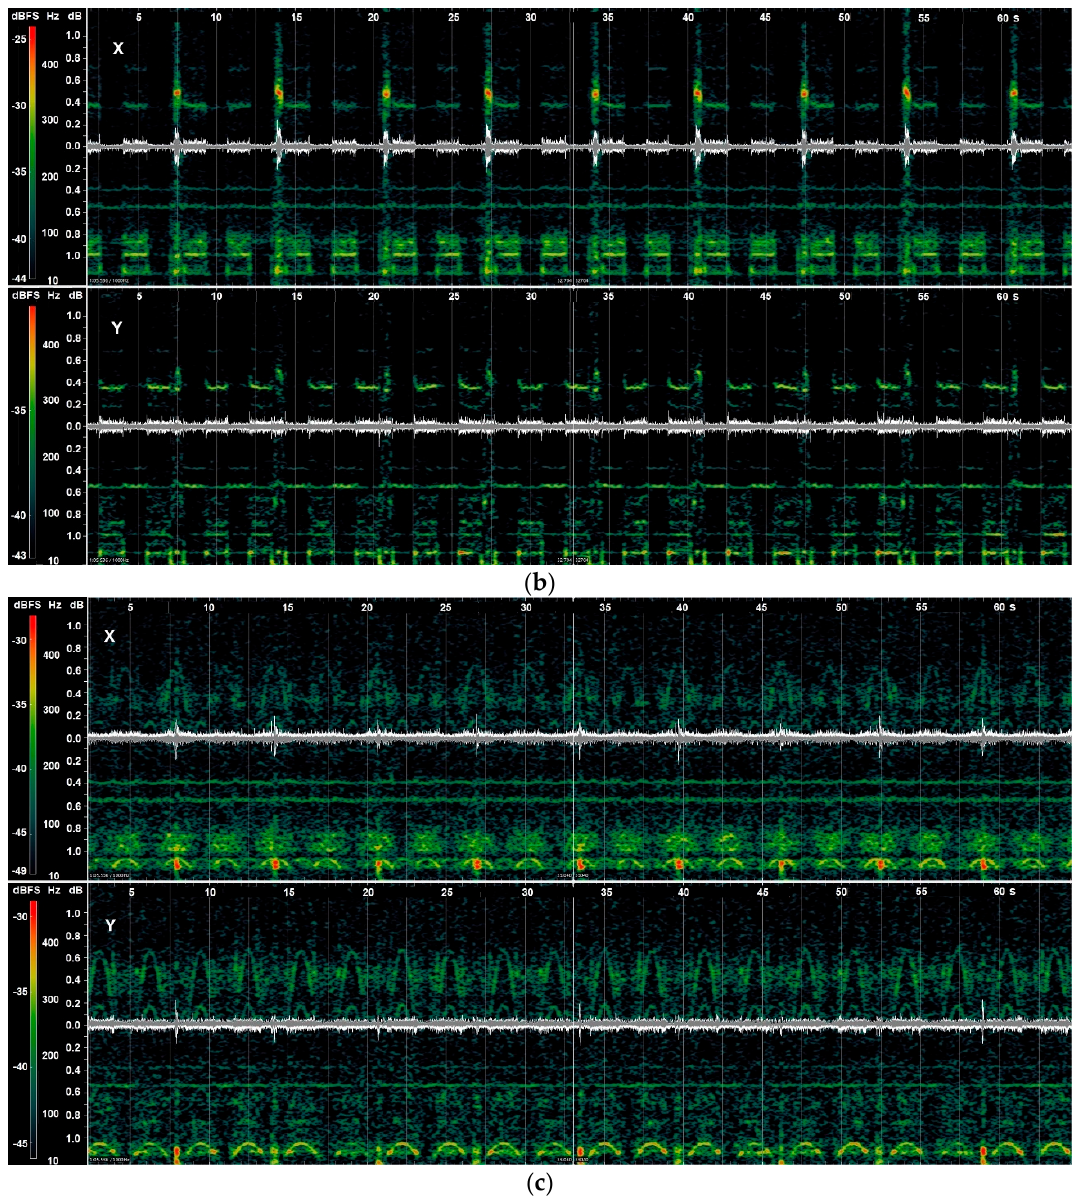
Figure 9. The spectrograms of printer vibrations (1 min measurement sessions) during the printing of: ( a ) trihedron object, ( b ) tetrahedron object, ( c ) tube object.